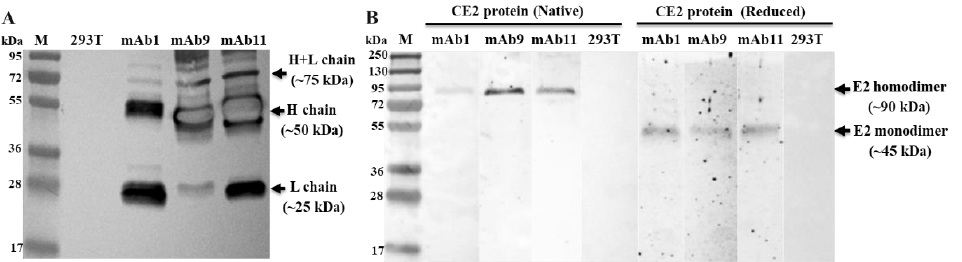
Figure 5. Analysis of the expression and CE2-binding activity of porcine mAbs by Western blotting. ( A ) Expression of porcine mAbs in 293T cell. Supernatants from H1 + λ 1 (mAb1), H9 + κ 9 (mAb9), H11 + κ 11 (mAb11) transfected 293T cells were loaded on Mini-Protean TGX Gel (Bio-Rad, CA, USA). Supernatant from non-transfected 293T cell was used as control. The proteins were then transferred to PVDF membrane. The membrane were blocked and then incubated with anti-pig IgG (Sigma, Saint Louis, MO, USA). ( B ) Porcine mAbs can bind CE2 protein. Purified CE2 proteins were treated without (Native) or with β -mercaptoethanol (Reduced) and separated by SDS-PAGE in a Mini-Protean TGX Gel. The proteins were then transferred to PVDF membrane. The membranes were blocked and then incubated with supernatants of mAb1, mAb9, mAb11, and 293T cell, respectively. M, moledular weight marker.